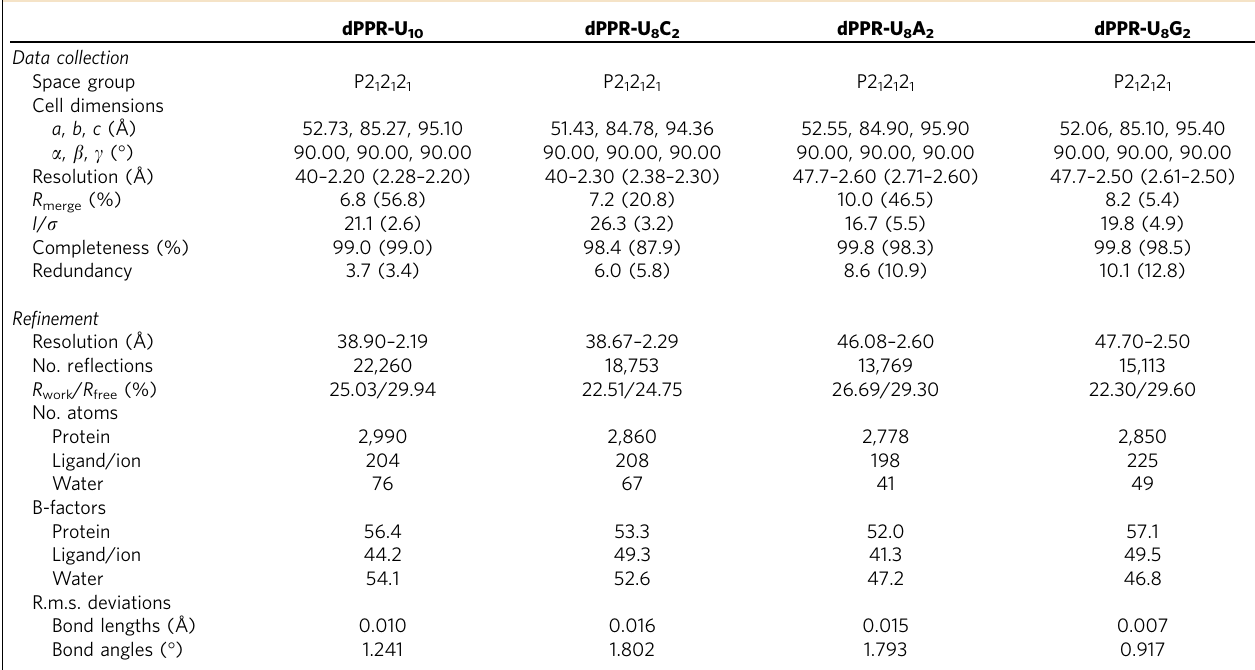
R.m.s., root mean square. Values in parentheses are for the highest resolution shell. R merge ¼ S h S i | I h , i (cid:2) I h |/ S h S i I h , i , where I h is the mean intensity of the i observations of symmetry related reflections of h . R ¼ S | F obs (cid:2) F calc |/ S F obs , where F calc is the calculated protein structure factor from the atomic model ( R free was calculated with 5% of the reflections